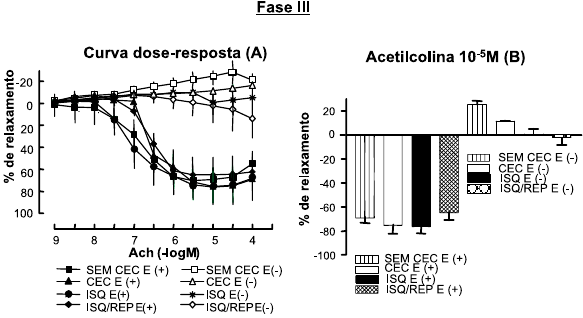
Fig. 3 - Fase III (Krebs com magnésio restaurado): A - Curvas dose-respostas à acetilcolina (ACh) em anéis de artérias coronárias caninas, contraídas com PGF a (2 x 10 -6 M), na 2 presença de indometacina (10 -5 M); B - Efeitos da dose 10 -5 M